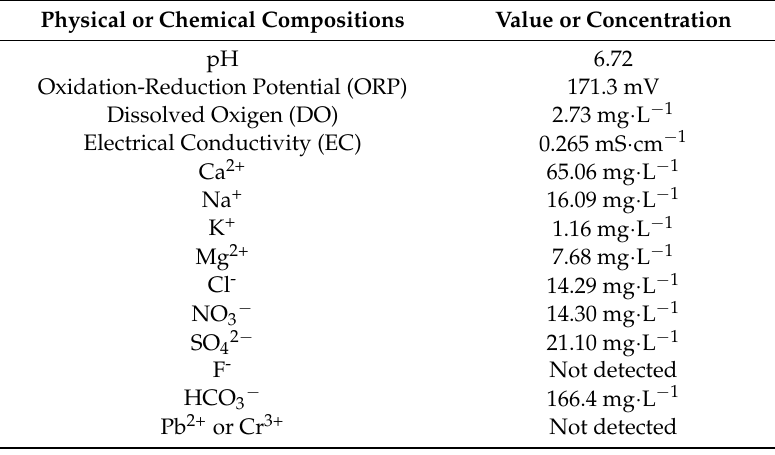
Table 2. Physical and chemical compositions of real water samples collected from Yullyang-dong, Sangdang-gu, and Cheongju-Si, Republic of Korea ( N = 3, mean values reported here, the standard deviation is less than 5%). Physical or Chemical